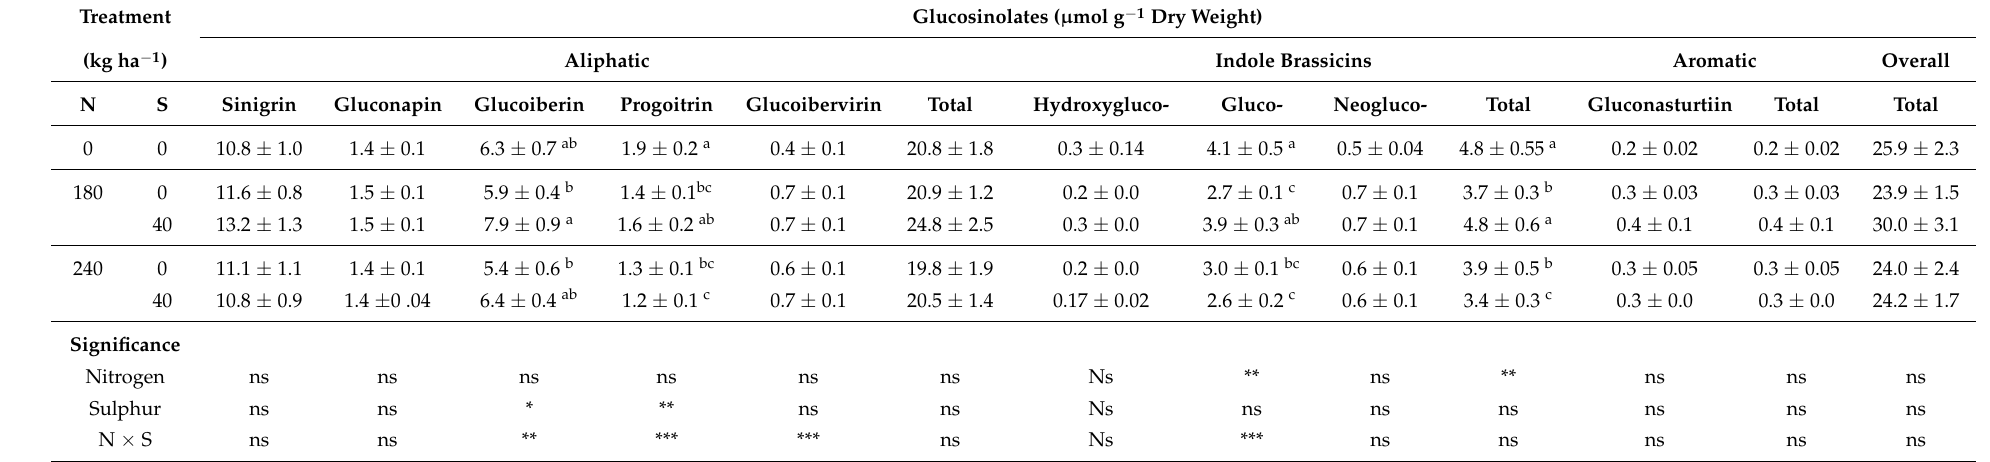
Table 6. The effects of nitrogen and sulphur fertilisation on the individual glucosinolate levels determined for cabbage heads and the nitrogen and sulphur interactions.